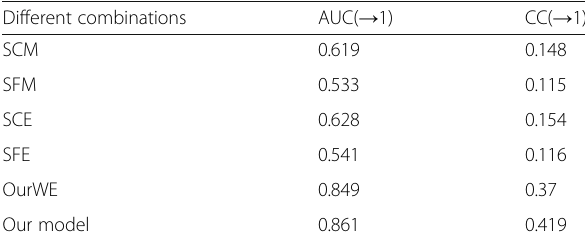
Table 2 Comparison between different component orders in the database in [18]